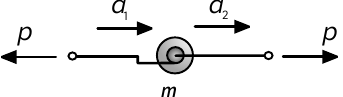
Figure 2. Mechanical model of an inerter element.